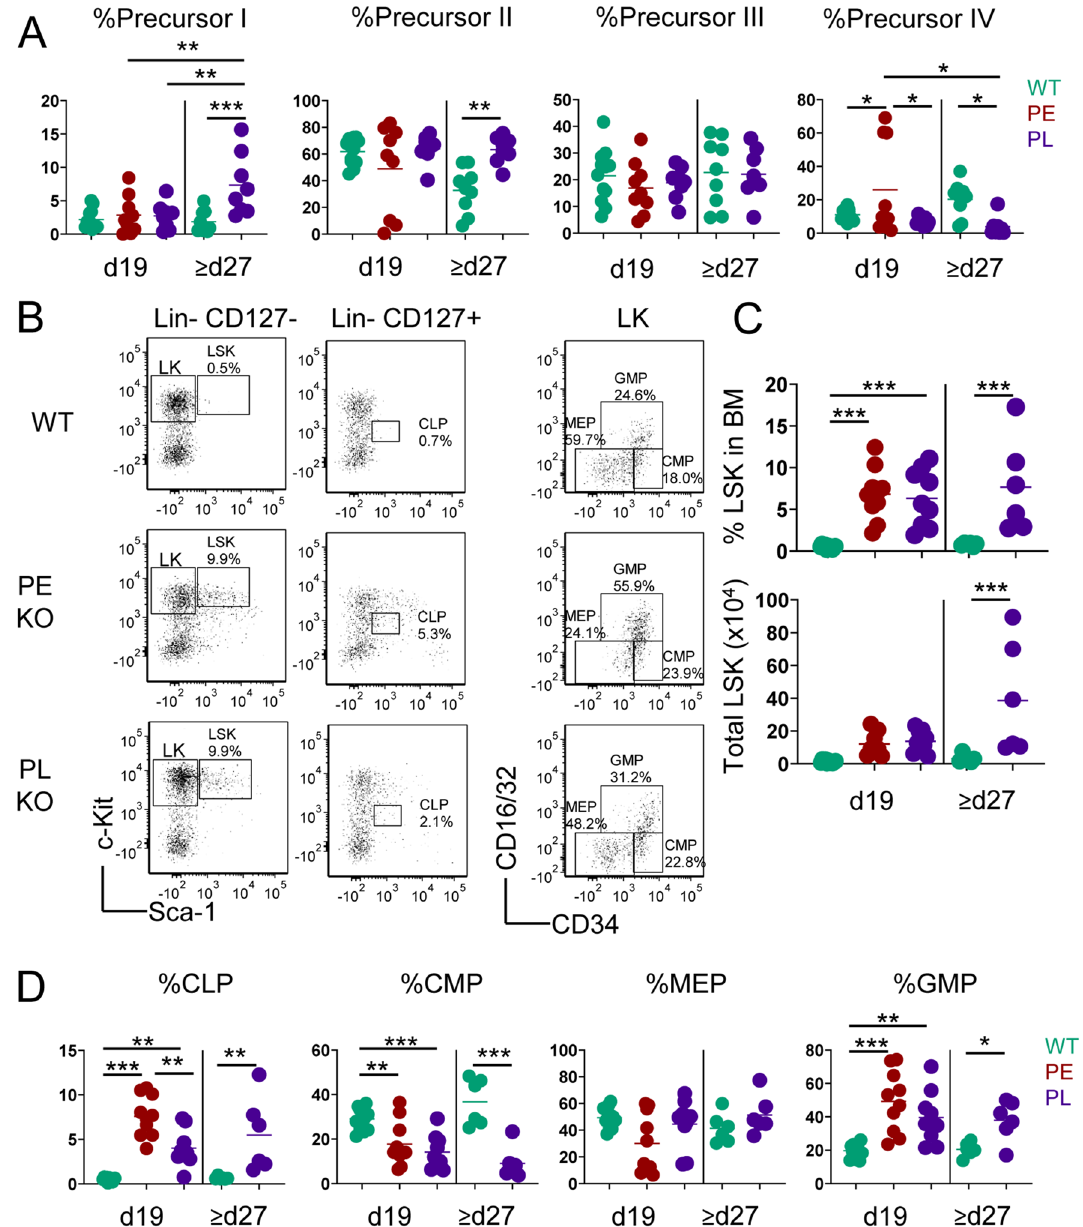
Figure 3. IL-2Rα-KO mice exhibit kinetic-dependent differences in CLP and RBC precursor frequency. ( A ) Frequency of RBC precursor analysis by expression of CD71 and Ter119 in WT and IL-2Rα-KO mice at day 19 and day ≥ 27. ( B ) Representative flow plots for hematopoietic progenitor populations in BM of 19-day-old WT and IL-2Rα-KO mice. ( C ) Frequency and total number of LSK cells in 19-day-old and late endpoint (d27+) WT and IL-2Rα-KO mice. ( D ) Frequency of hematopoietic progenitor populations in 19-day-old and late endpoint (d27+) WT and IL-2Rα-KO mice. Statistics: one-way ANOVA with Benjamini–Hochberg FDR correction; *p < 0.05, **p < 0.01, ***p < 0.001; n = 9–12 mice per experimental group. Non-significant comparisons are not shown. For total number, comparisons between mice of different ages are not shown to due differences in mouse